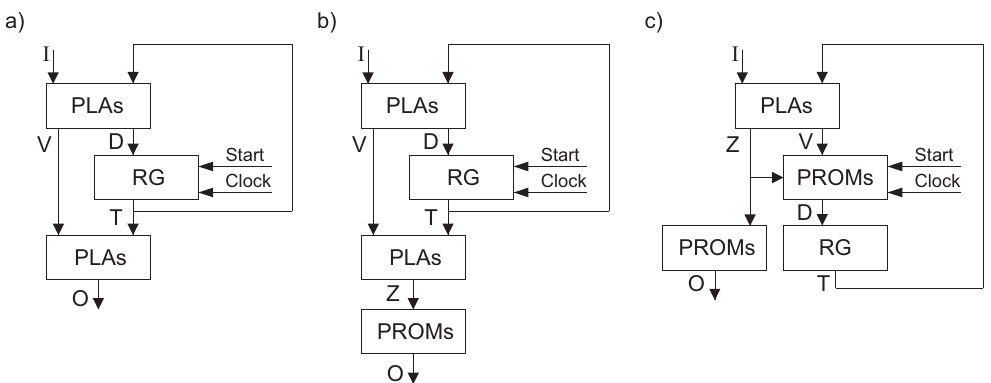
Figure 17. Structural diagrams of Mealy FSMs with transformation of states into outputs (a ), states into collections of outputs ( b ), and collections of outputs into states ( c